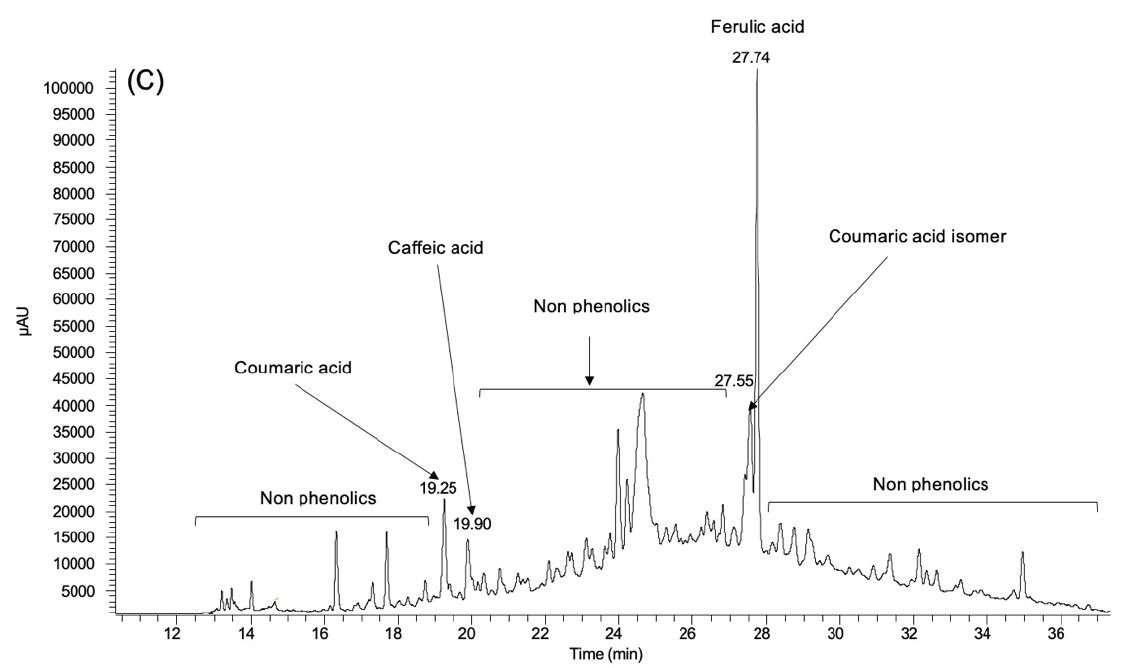
Figure 1. HPLC-DAD chromatograms of polyphenols standards used for identification and quantification in P. hybrida extracts (( A )—leaf extract; ( B )—fruit extract; ( C )—stem bark extract).